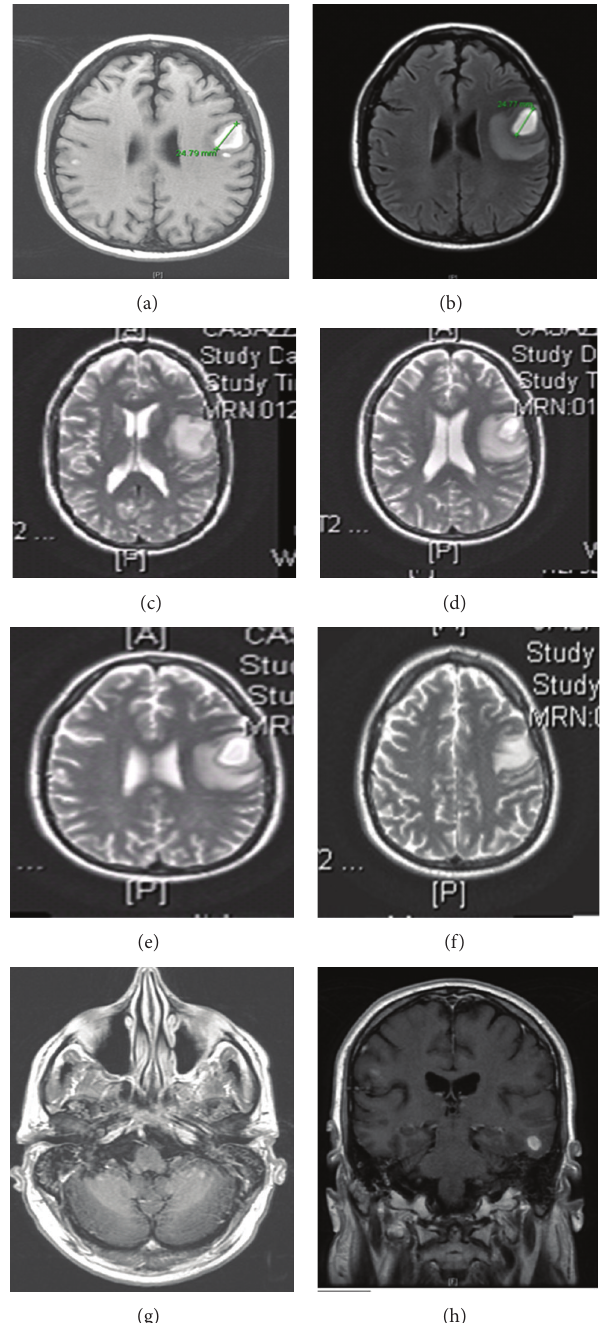
Figure 6: Magnetic resonance imaging (on discharge) showing improvement in multiple foci of hemorrhage, and dominant focus within the left frontal lobe subcortical matter appears to be stable with adjacent